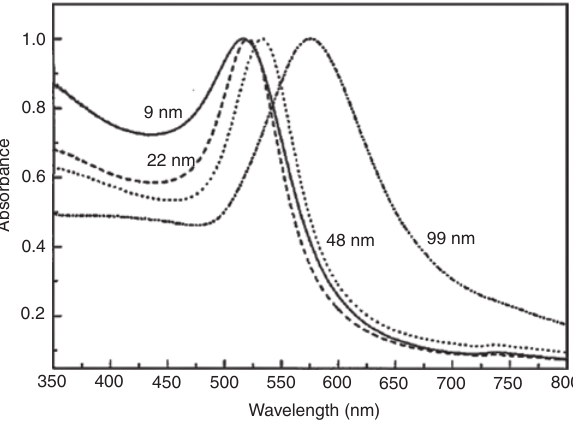
Figure 6: UV-vis absorption spectra of 9-, 22-, 48-, and 99-nm gold nanoparticles in water. All spectra are normalized at their absorp- tion maxima, which are 517, 521, 533, and 575 nm,